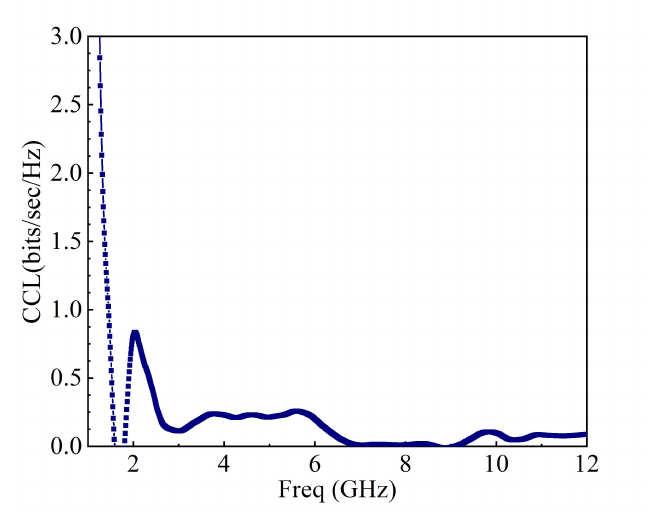
Figure 30. Channel capacity loss (CCL) of the MIMO antenna system.